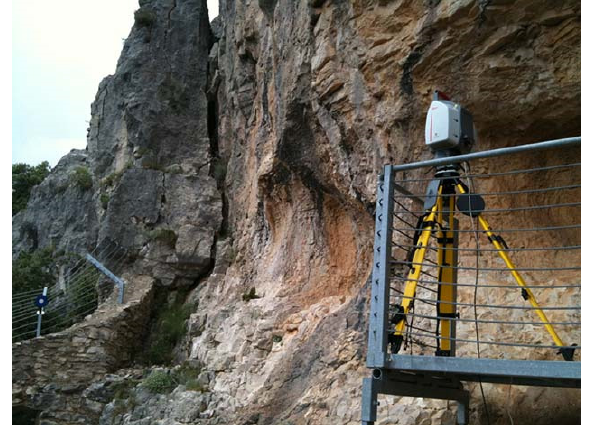
Figure 2. Terrestrial laser scanning setup targeting targeting Shelters I and II